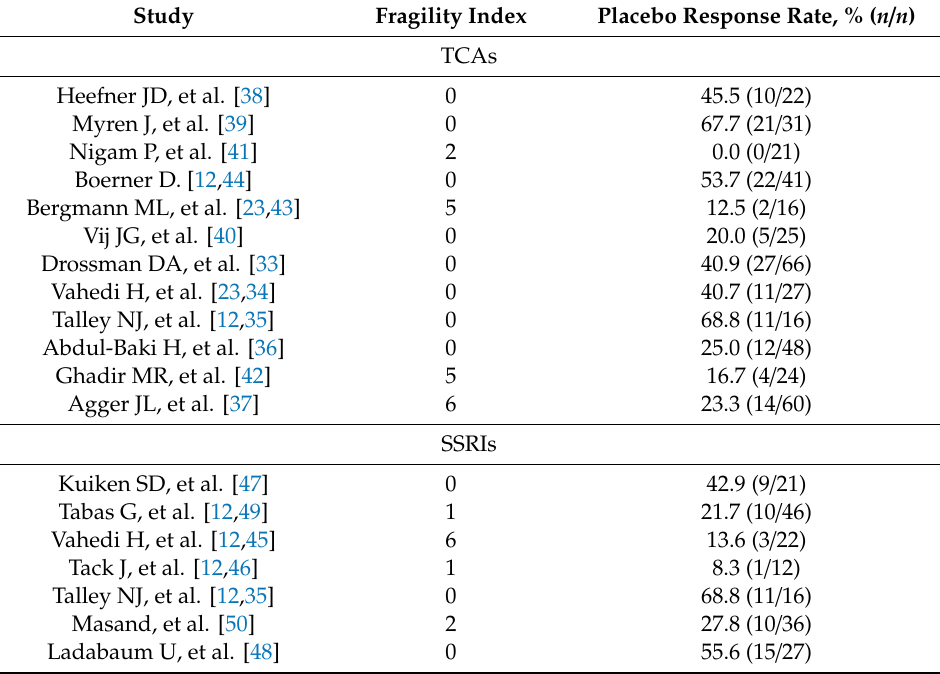
Table 3. Fragility index for clinical studies of antidepressants in irritable bowel syndrome. Study Fragility Index Placebo Response Rate, % ( n / n